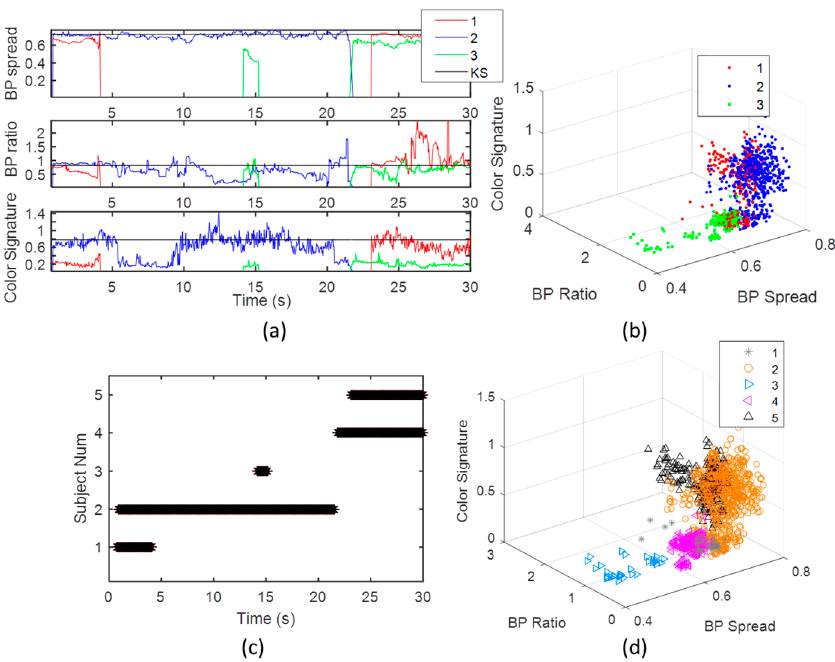
Figure 7. The five KIs and their corresponding three Kinect subject assignments in time ( a ); their corssponding mapping to Kinect indexes in the active set ( b ); the “life duration” of the five KIs ( c ); and the KIs in feature space ( d ).